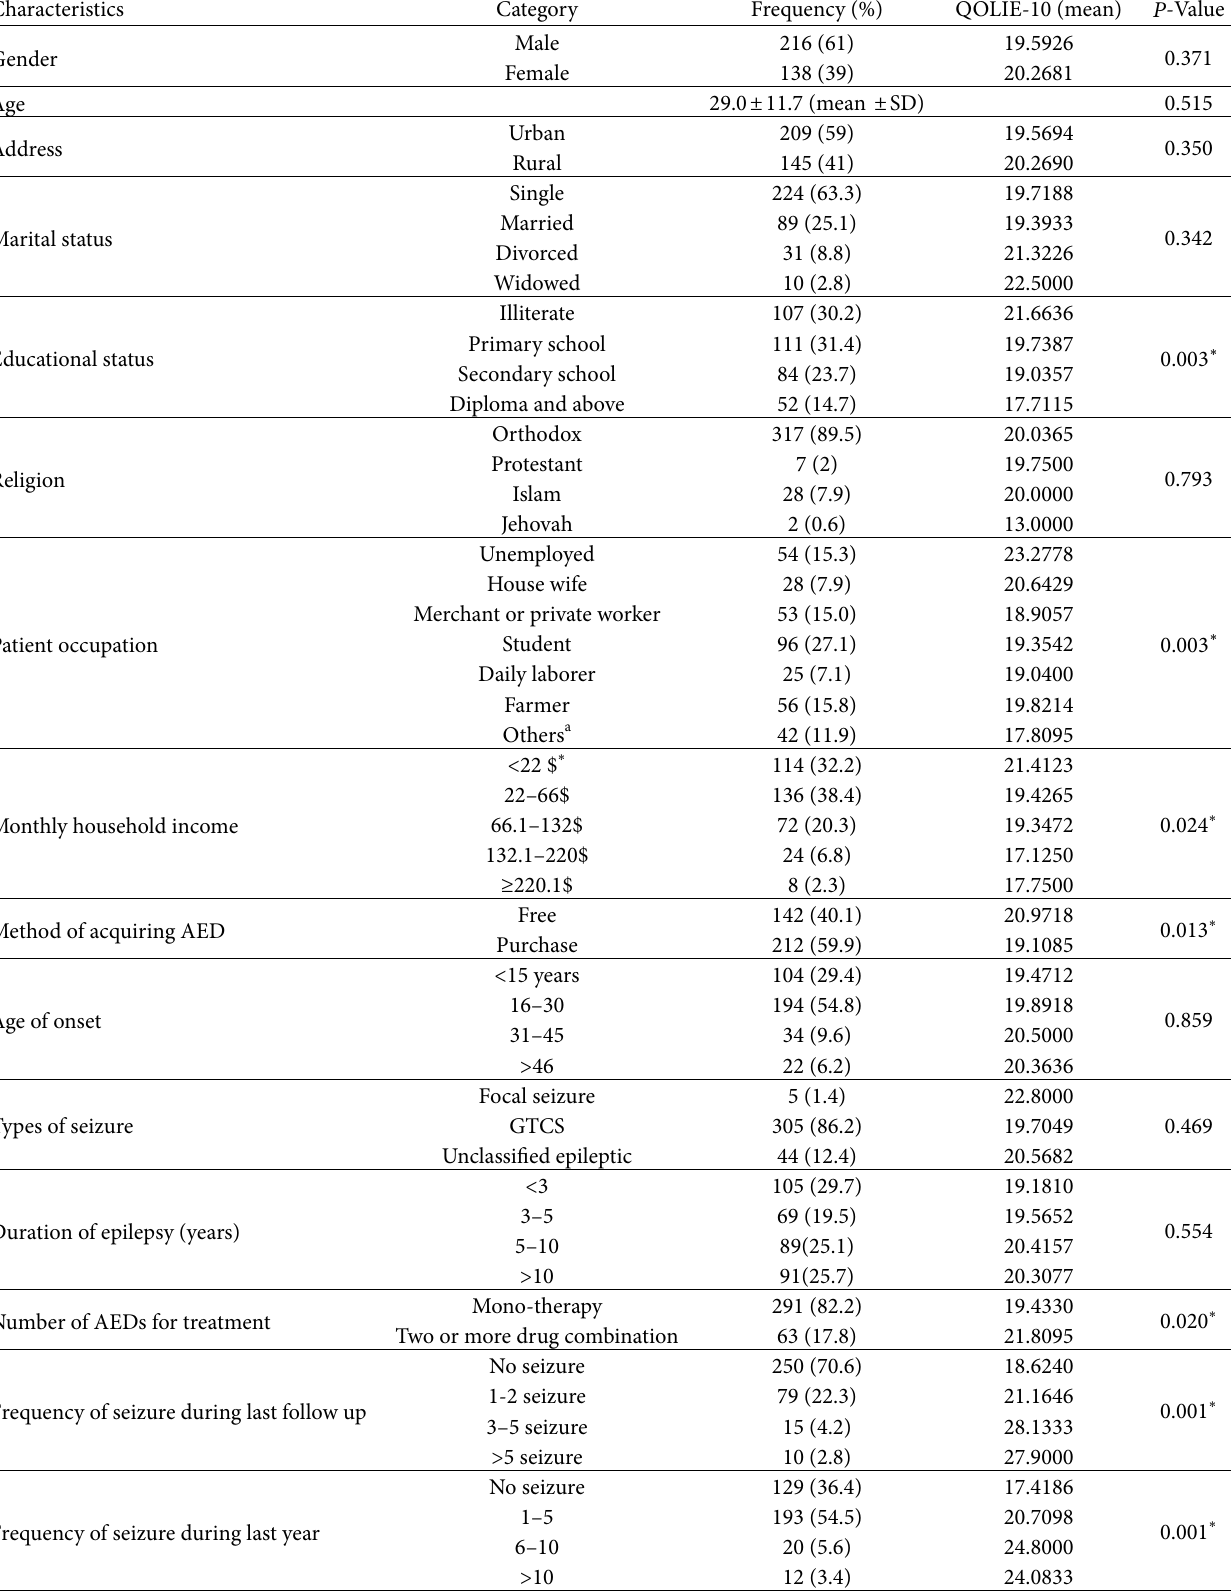
Table 4: Association of socio demographics and clinical characteristics with quality of life of epileptic patients, Northwest Ethiopia;